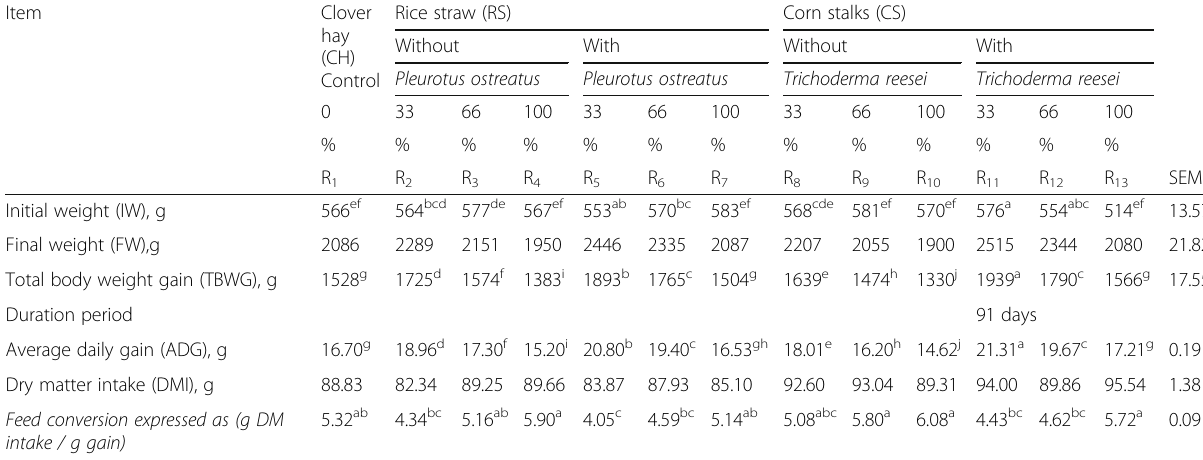
Table 5 Effect of interactions between biological treatments, roughage source and replacement levels (T × S × L) on nutrient growth performance of the experimental groups